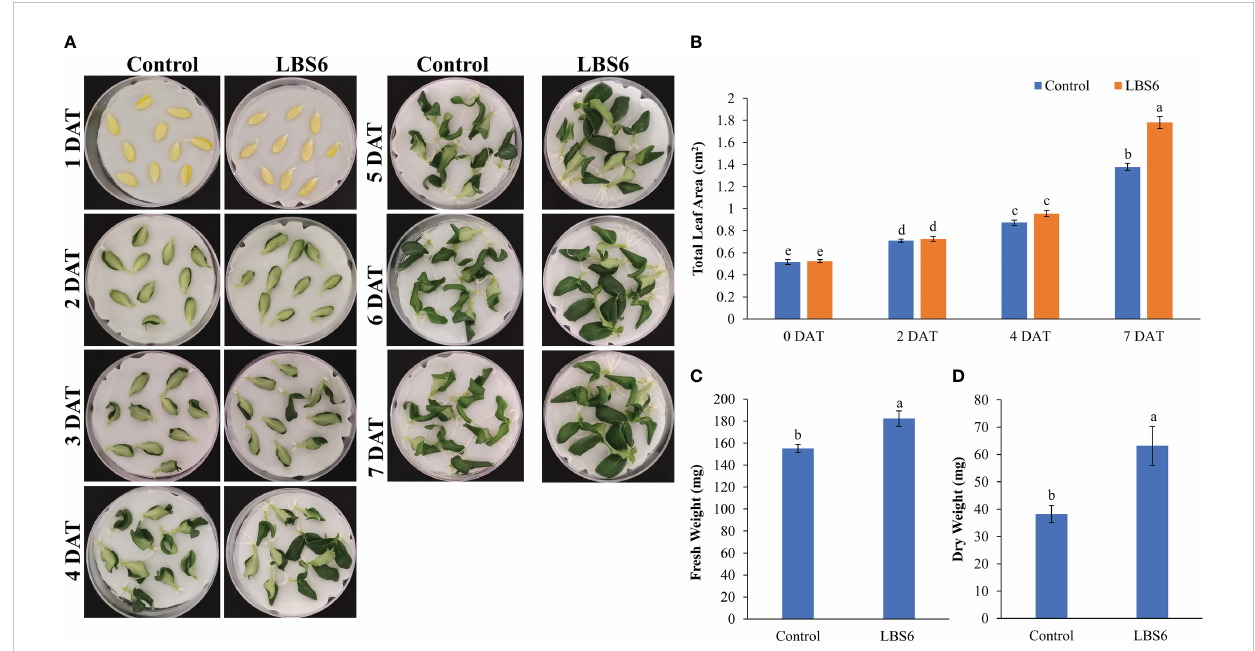
FIGURE 1 Cotyledon expansion assay (A) Effect of LBS6 on expansion of cotyledons. Cotyledons treated with sterile distilled water served as control. (B) Total area of seven-day old cotyledons treated with water (Control) and LBS6. Fresh (C) and dry (D) weight of the seven-day old cotyledons treated with water (Control) and LBS6. The values were presented as mean ± SE of three independent replicates, and signi fi cantly different mean values were represented by different